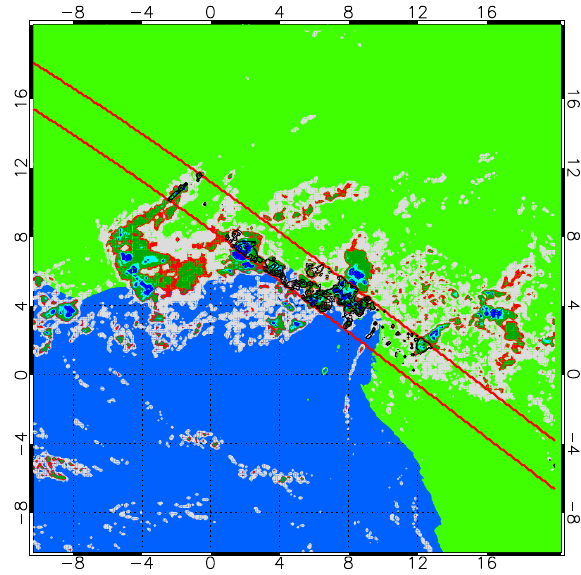
Fig. 1. Example of a collocated SEVIRI image with a TRMM-PR overpass over the Guinean coastal area at 16 May 2006, 11:15UTC. SEVIRI rain rates are in color-filled contours, while TRMM-PR rain rates are indicated by open contours. Countour intervals are drawn at 0.1, 0.5, 1, 5, and 10mmh − 1 . The red lines indicate the edges of the TRMM-PR swath.